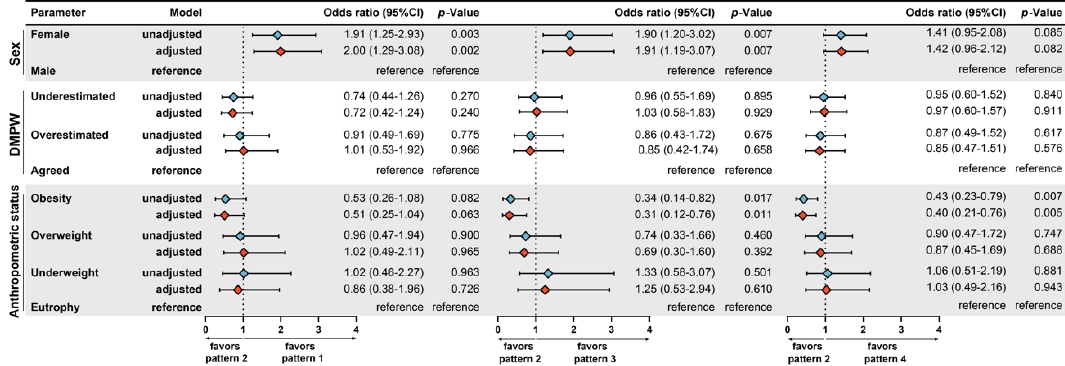
Figure 3. Multinomial logistic regression to test independent associations with the distinct dietary patterns. Adjustment was performed for all variables presented in the figure. The dietary pattern 2 profile was used as reference to test associations between variables and patterns 1, 3, or 4. The statistical significance was estimated through a multinomial logistic regression model. The results were also weighted for study design effect (Deff). The variable dietary pattern displayed low degree of intra-conglomerate heterogeneity (Deff = 1.12). Thus, the study design had low impact on the variance of food pattern values in the study participants. Abbreviations: CI—confidence interval; DMPW—divergence between measured and perceived weight.